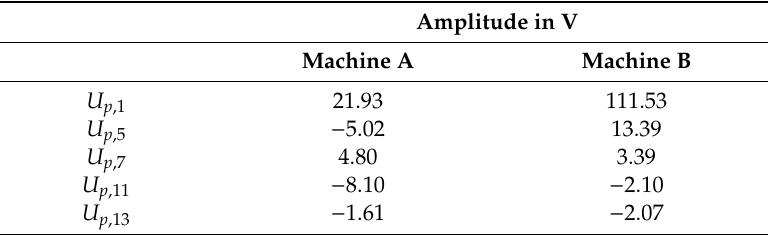
Table 4. Amplitudes of the back electromotive force for machine A and B.